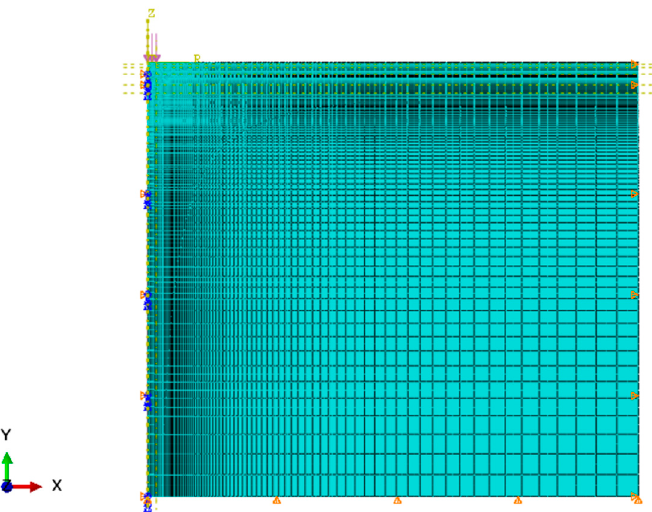
Figure 2. Finite element method mesh.